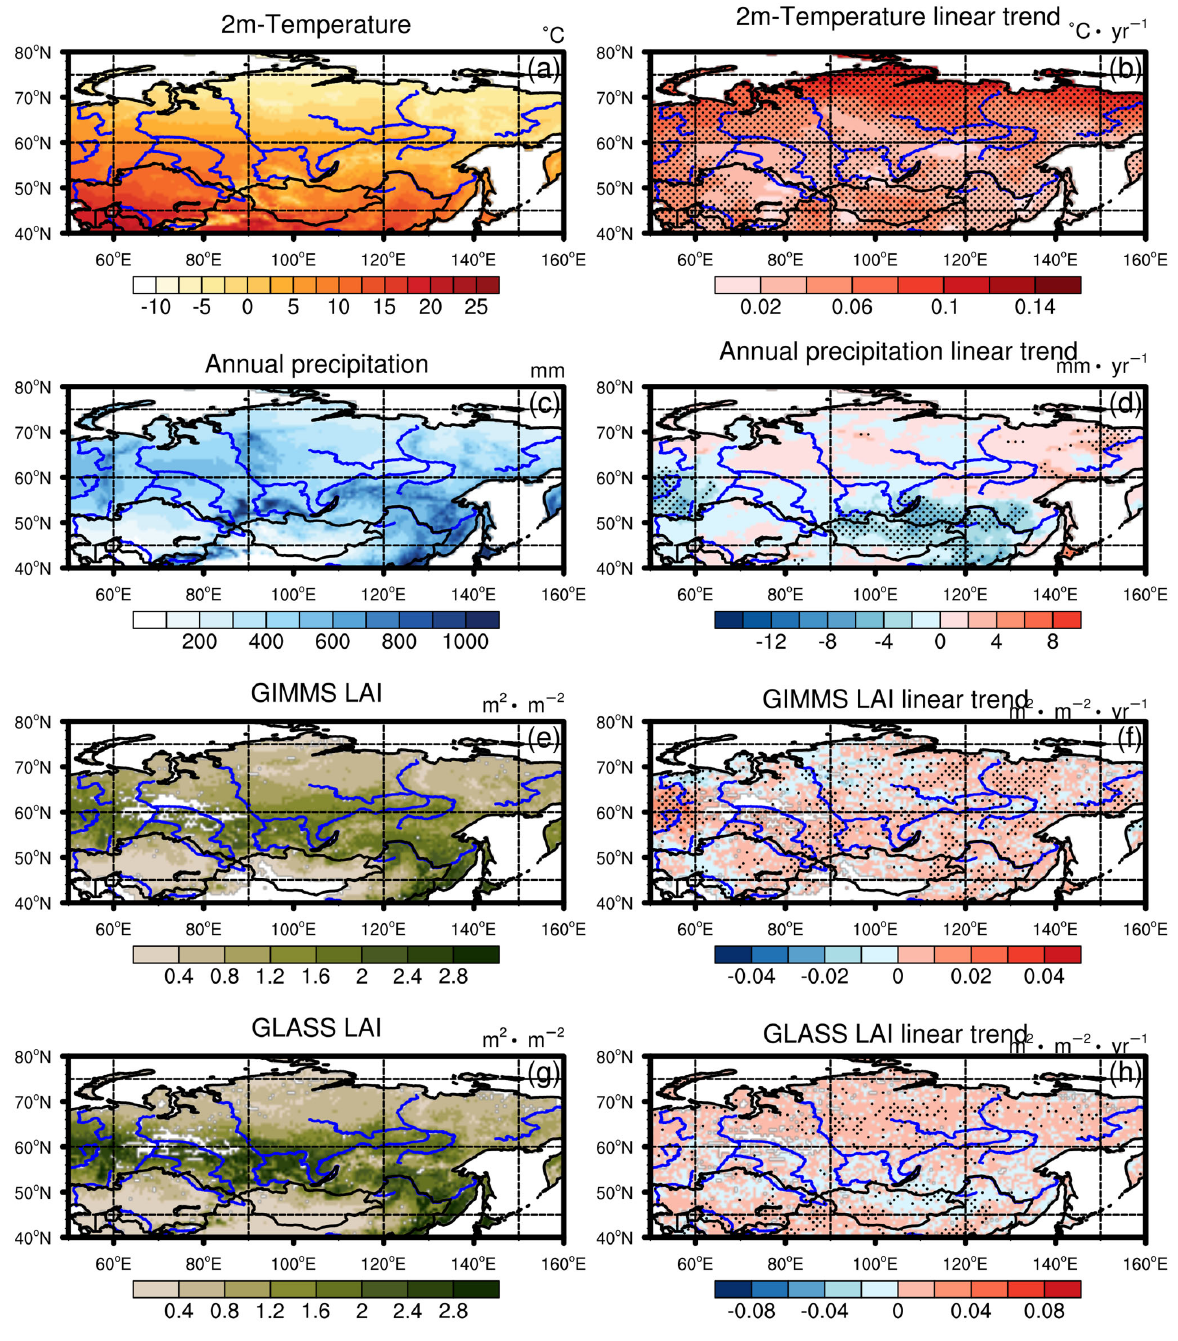
Figure 2. Averages of 2 m temperature ( a ), total precipitation ( c ), GIMMS LAI ( e ), and GLASS LAI ( g ) from April to November in 1982–2016 and their linear trends ( b , d , f , h ). The stippling means the trends are statistically significant at the 5% level based on the two ‐ tailed Student’s t ‐